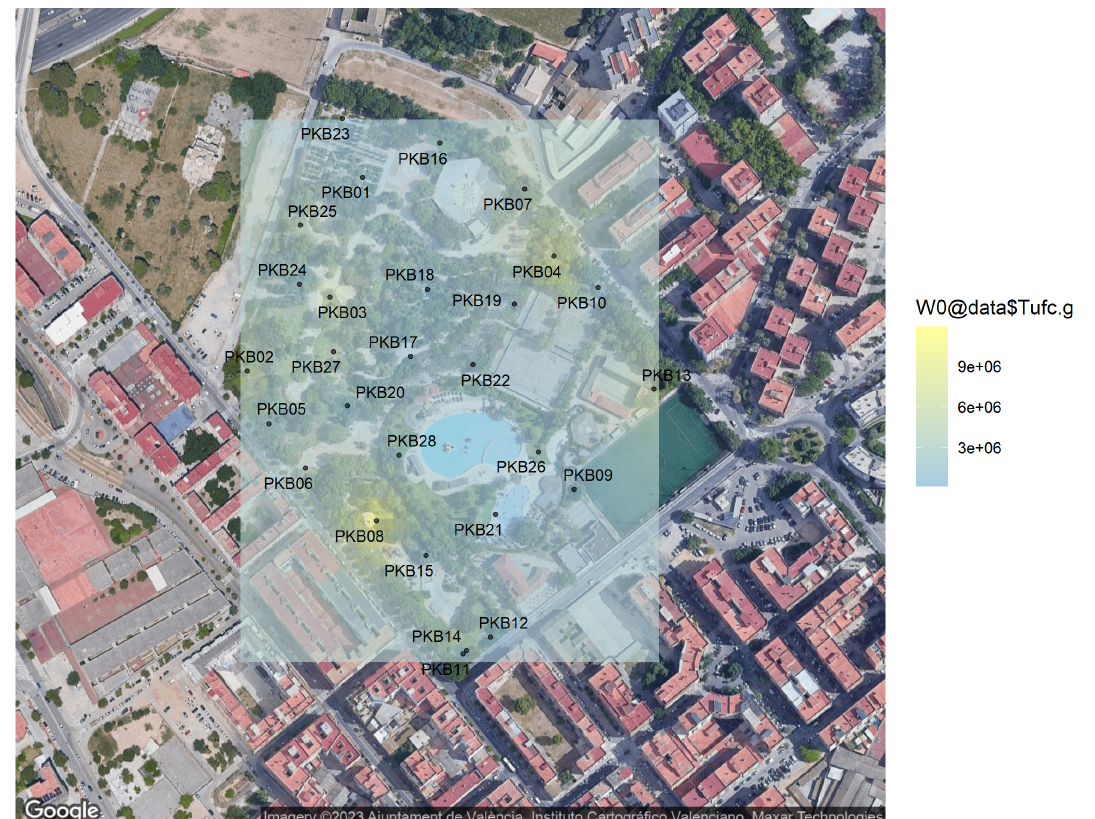
Figure 3. Kriging mapping of isolated microorganisms at the park in